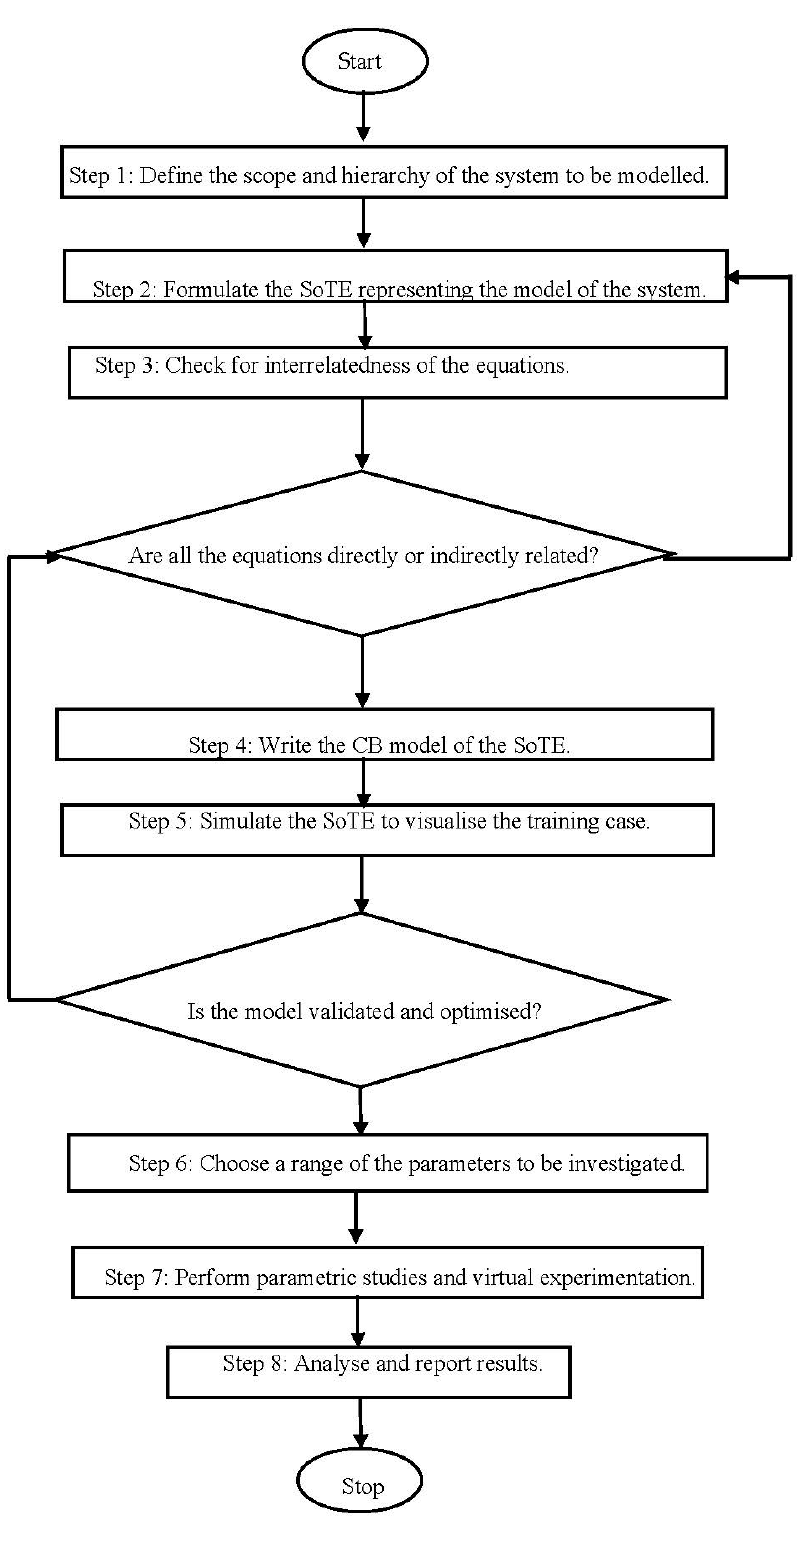
Figure 1. Flowchart for implementing the CBM approach for solving SoTEs.